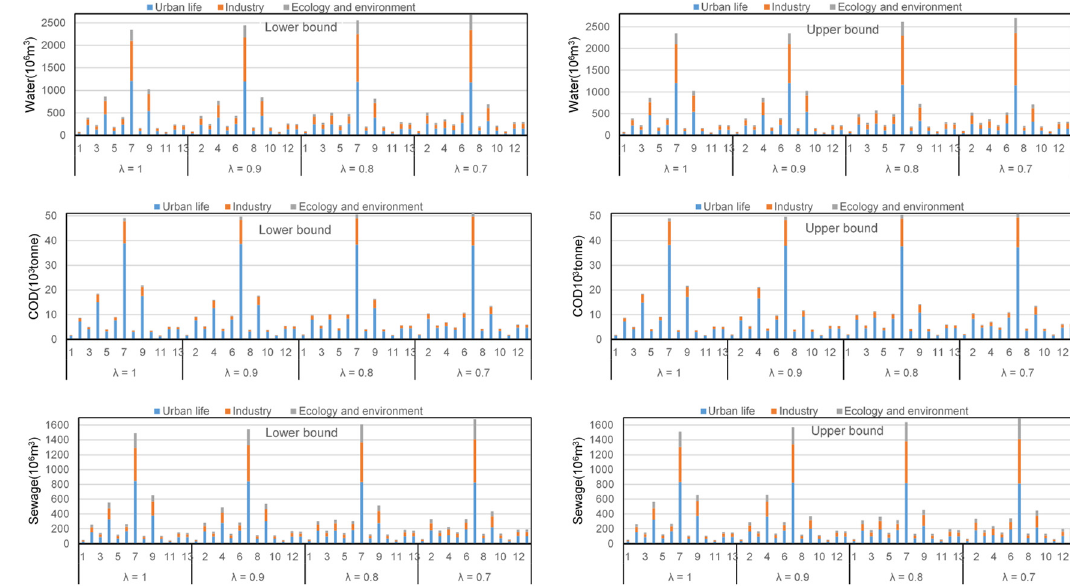
Figure 10. Water allocation, COD emission, and sewage discharge under di ff erent λ levels in S1. Note: λ = 1, 0.9, 0.8, 0.7; S1, Scenario 1; 1, Dengzhou City; 2, Nanyang City; 3, Pingdingshan City; 4, Xuchang